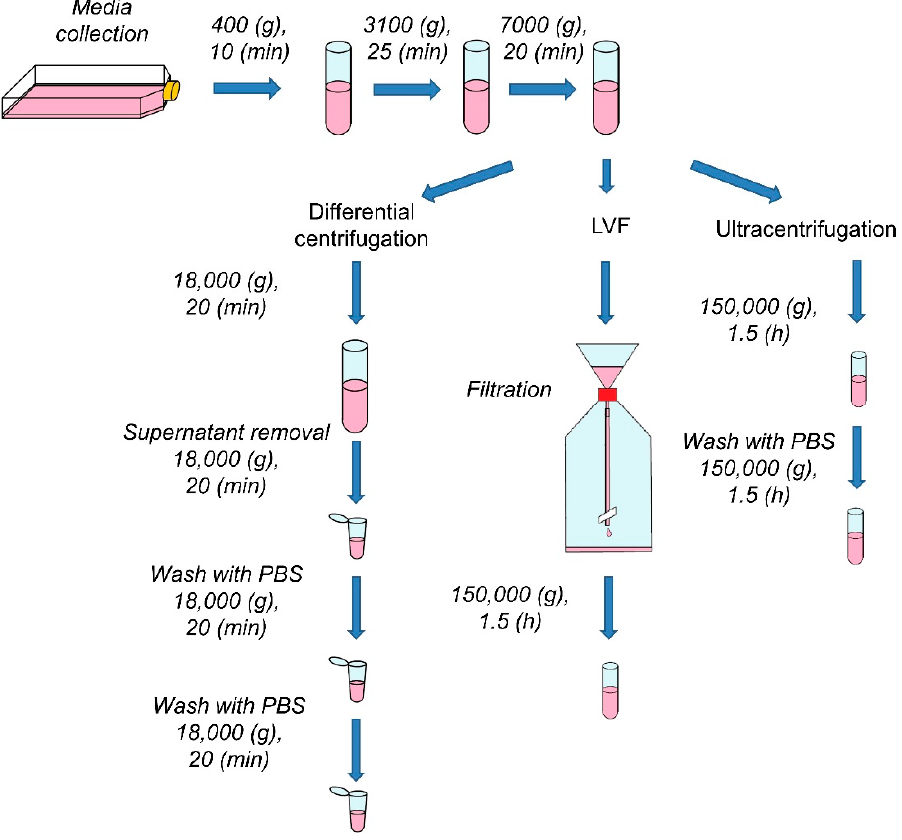
Figure 2. Scheme of the experimental design. After conditioned media collection, the samples underwent preparatory centrifugations to remove cells, cell fragments and apoptotic bodies. After the preliminary steps, EVs were isolated according to the procedure for each method. PBS (phosphate buffered saline).